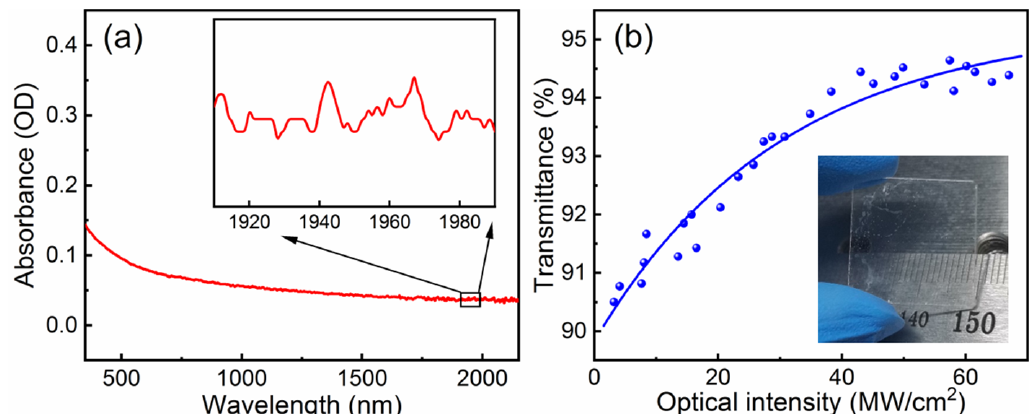
Figure 3. Optical characteristics of VS 2 . ( a ) The linear absorbance of the VS 2 nanosheets; ( b ) the nonlinear optical transmittance curve of the VS 2 SA. The inset of ( b ) presents a VS 2 film deposited on a glass substrate.